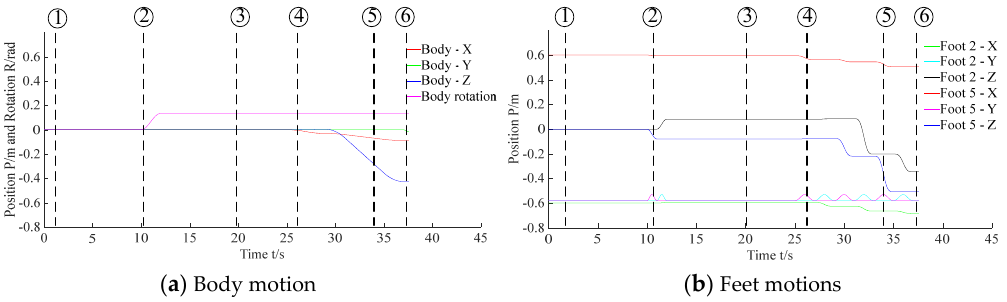
Figure 15. Motions of the body and feet in the process of visual locating.